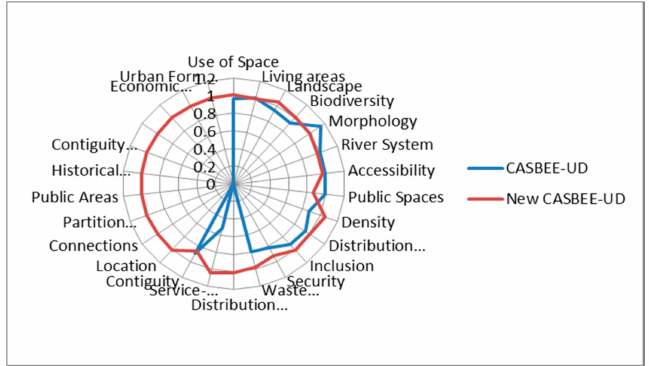
Figure 5. Evaluation result in radar form depicting the final score of each tool.